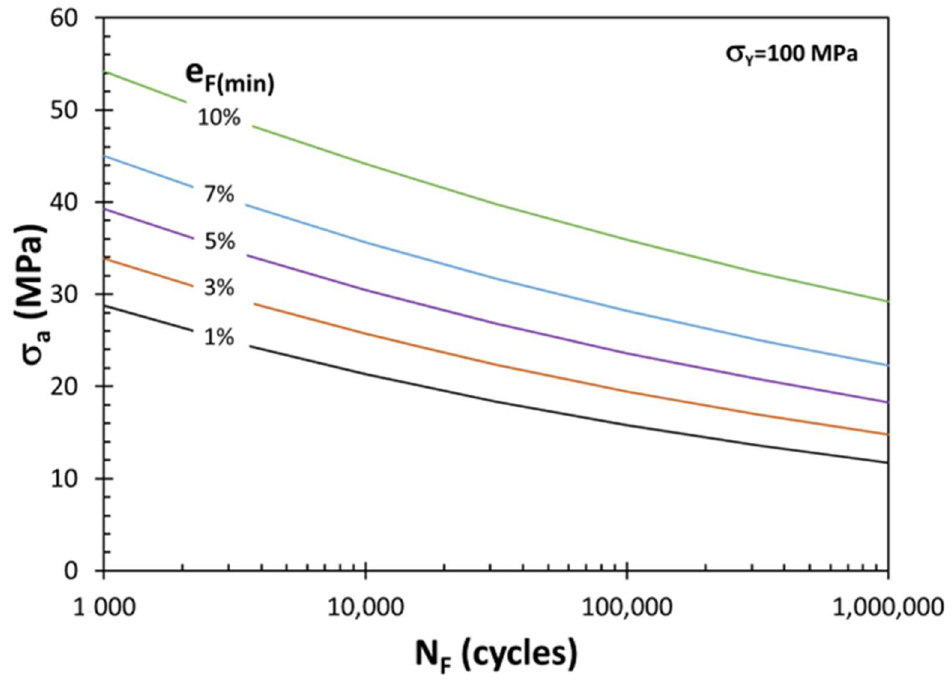
Figure 3. The S-N curves estimated by following the method developed previously [29] for a yield strength of 100 MPa and different levels of elongation. Fatigue strength is determined from these curves at N F = 10 6 cycles.